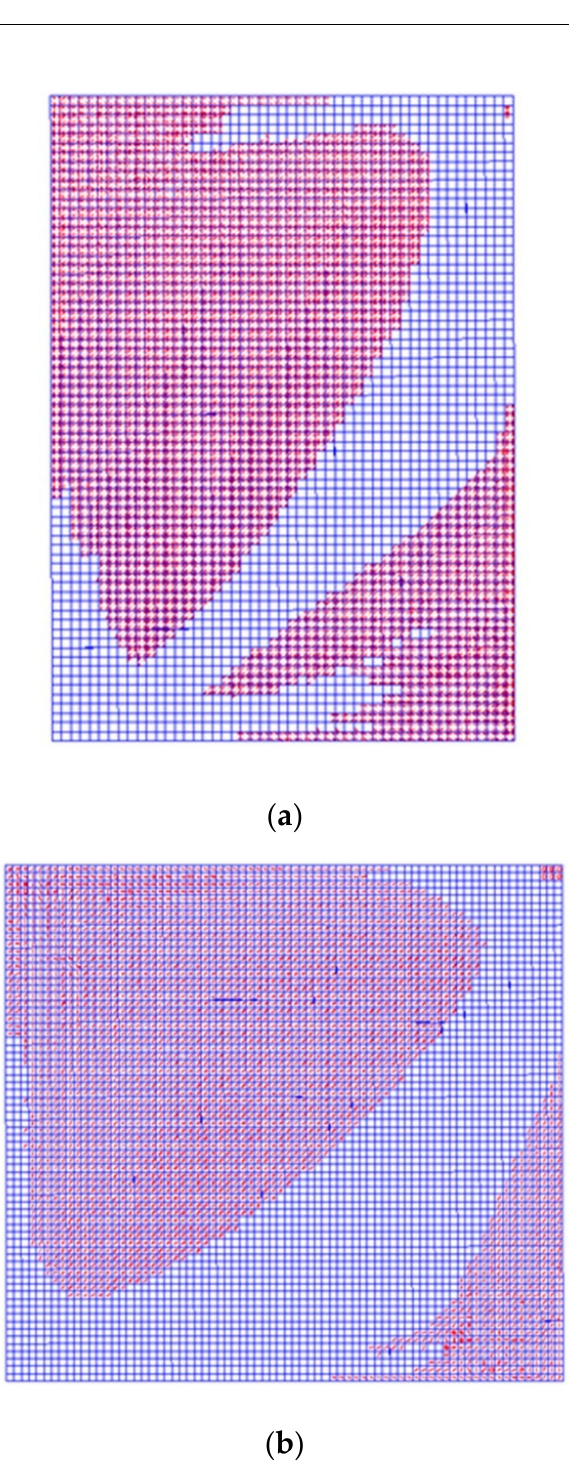
Figure 11. Crack distribution diagram obtained by finite element simulation when the drift angle reached 1/400: ( a ) specimen W1 and ( b ) specimen W2.